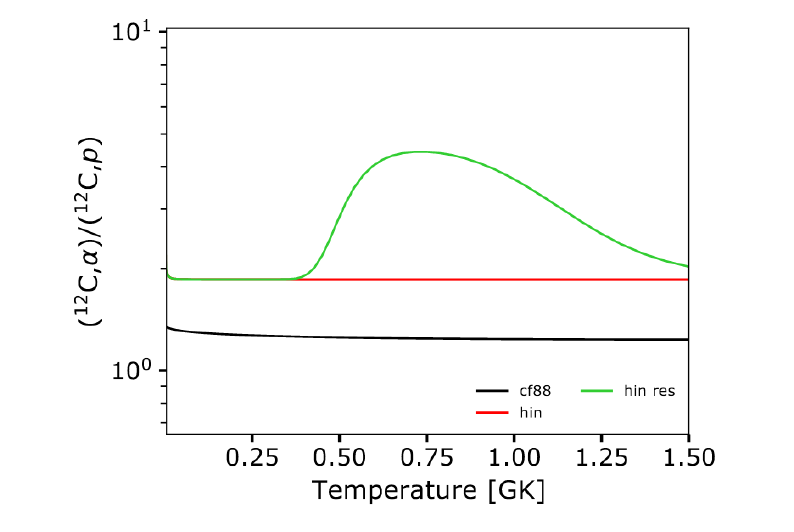
Figure 1. Ratio of the reaction channels in the valid temperature range for carbon burning for CF88, the Hin and HinRes models in the One-Layer